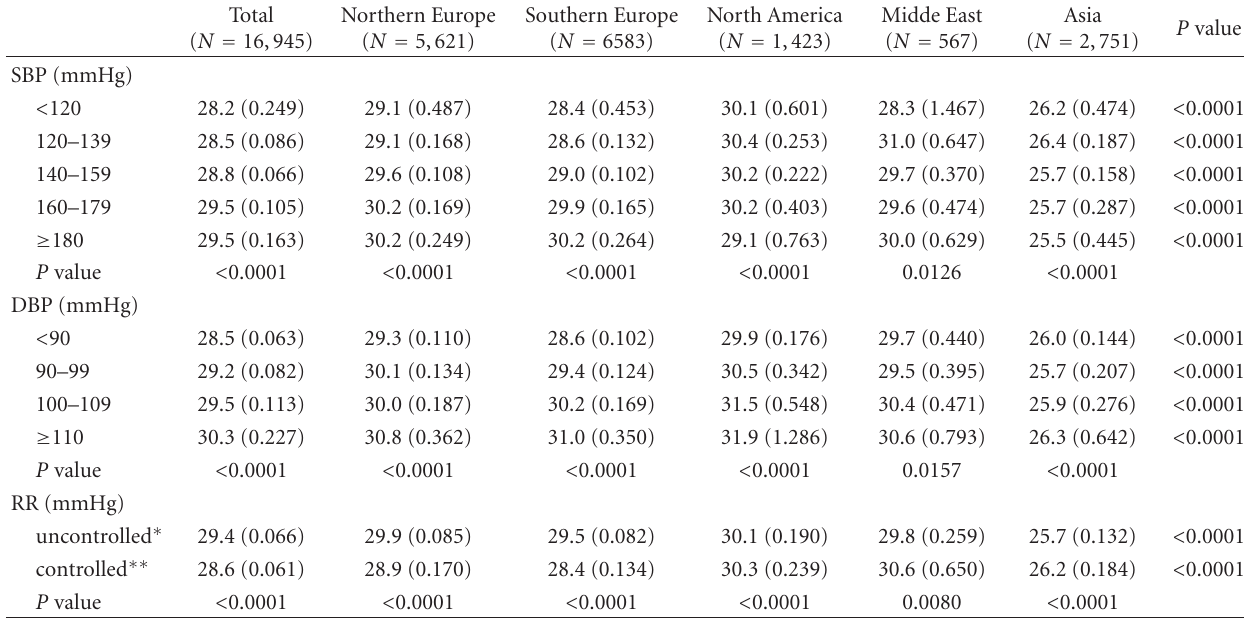
Table 2: Blood pressure and BMI (kg/m 2 ; mean ± SE; adjusted for age, gender).